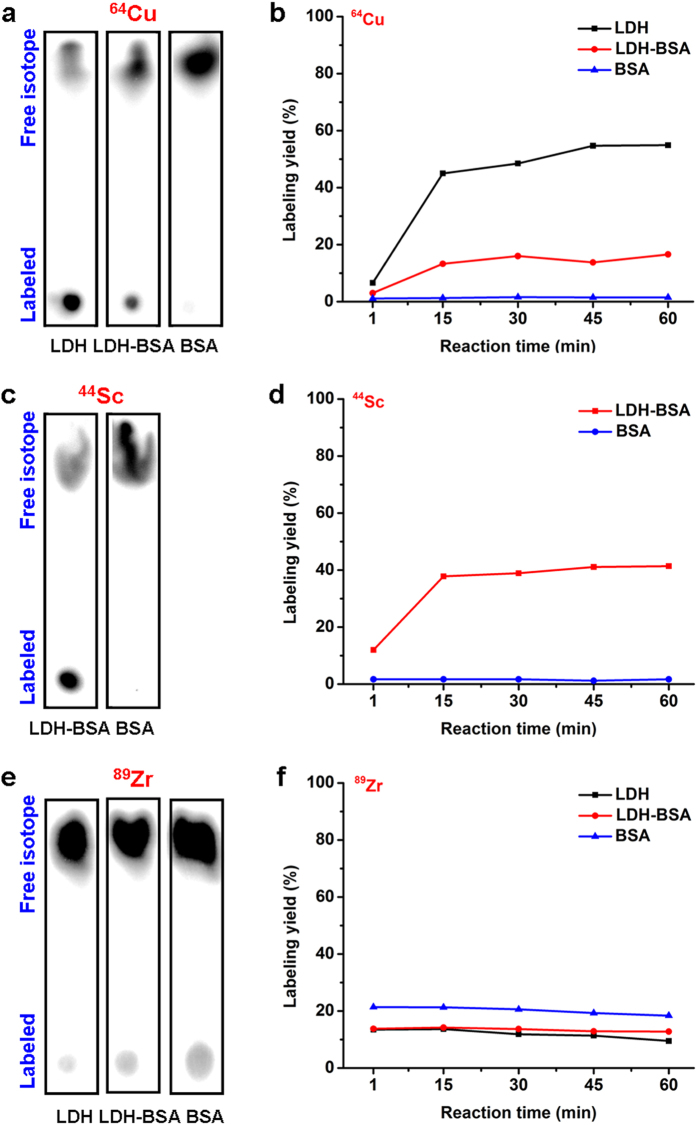
Chelator-free labeling of LDH nanoparticles.(a,c,e) Autoradiographic images of TLC plates of LDH, LDH-BSA and BSA after chelator-free labeling with 64Cu, 44Sc and 89Zr for 60 min. (b,d,f) The labeling yield of LDH, LDH-BSA and BSA after chelator-free labeling with 64Cu, 44Sc and 89Zr at different reaction times calculated from autoradiography images of TLC plates.